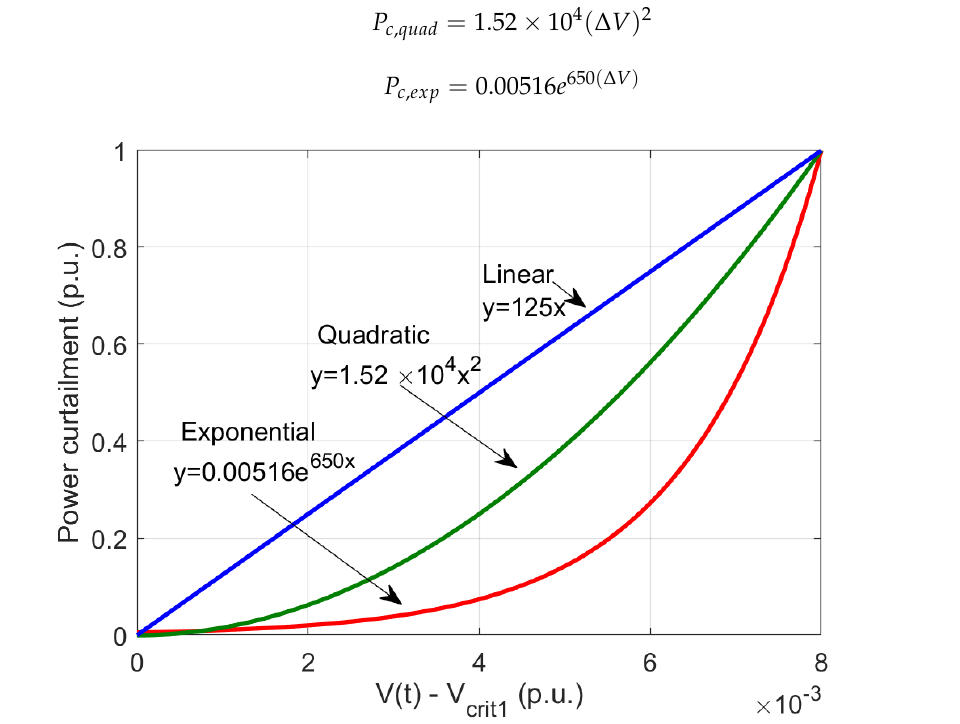
Figure 2. Linear, quadratic, and exponential droop for APC